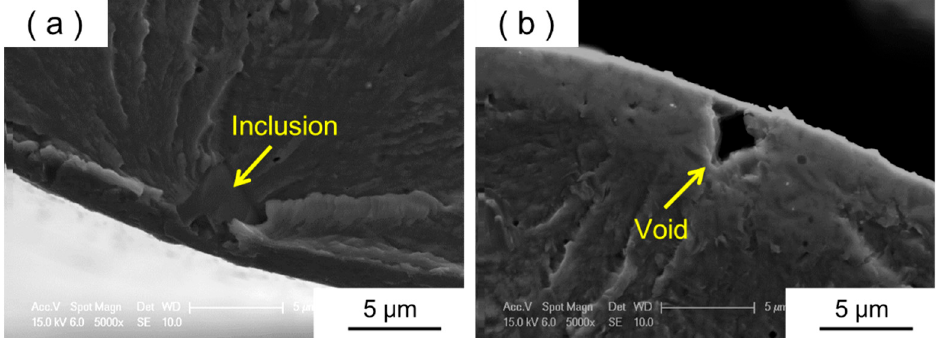
Figure 7. SEM-SE images of a pair of fracture surfaces of C300O300 wire after fatigue test. ( a ) Fracture surface containing Ti 4 Ni 2 O x inclusion acted as crack initiation site. ( b ) Counter part of fracture surface containing void corresponding to the trace of inclusion in ( a ). Table 3. Energy-dispersive X-ray spectroscopy (EDS) analysis of nonmetallic inclusions at the crack origins in a fatigue fracture surface of C300O300 wire.